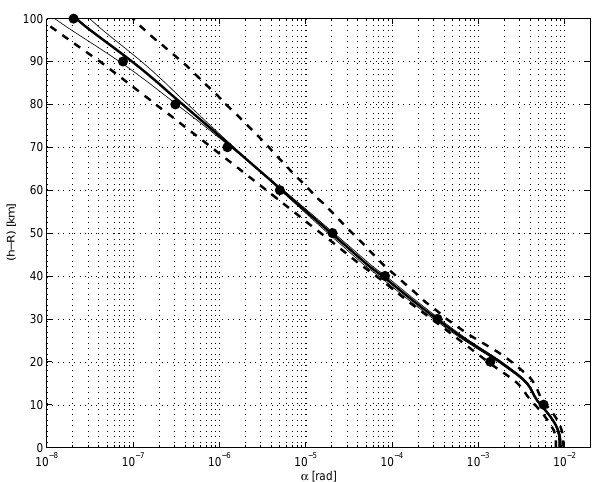
Figure 7. A typical transmittance measurement in a solar occulta- tion observed by ORA. Notice the strong absorption by the Pinatubo stratospheric aerosol around h − R (cid:39) 10km. The signal is produced by a current measurement and is virtually free of shot noise.